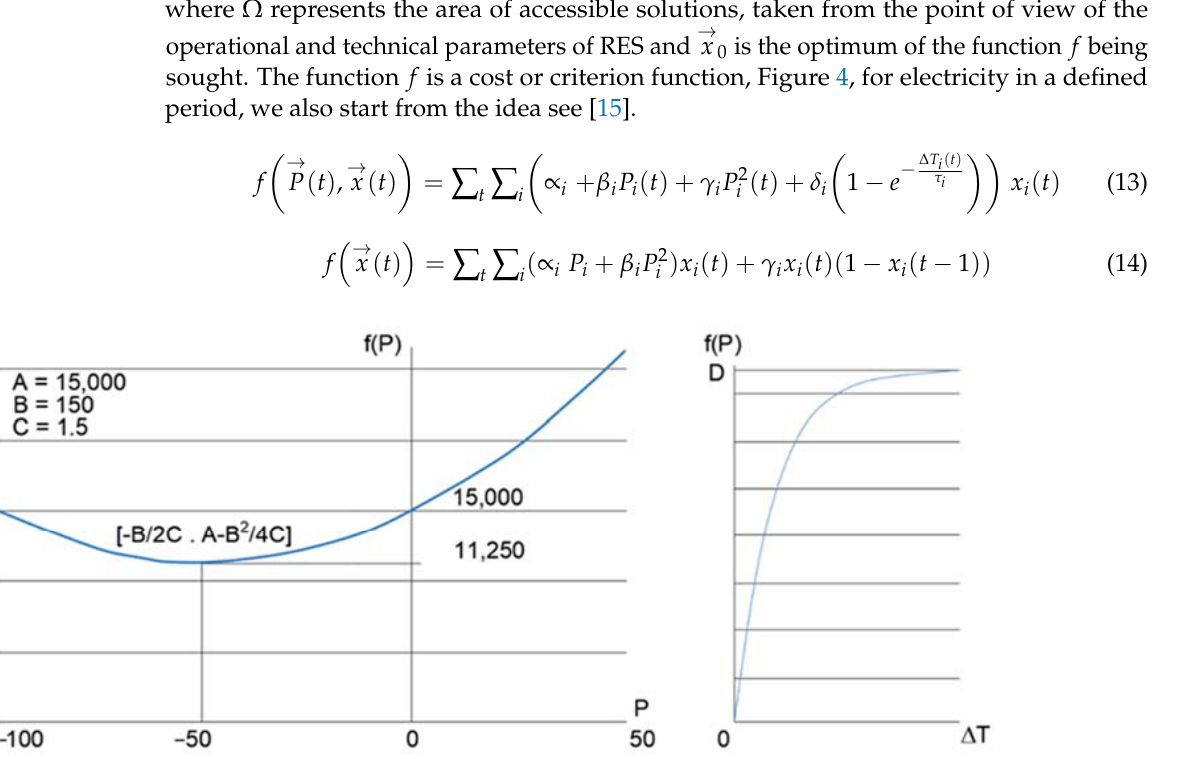
Figure 4. Dependence of operating costs on energy and downtime. Note: f ( P )—Start-up costs; ∆ T —Downtime; P —Operating costs.